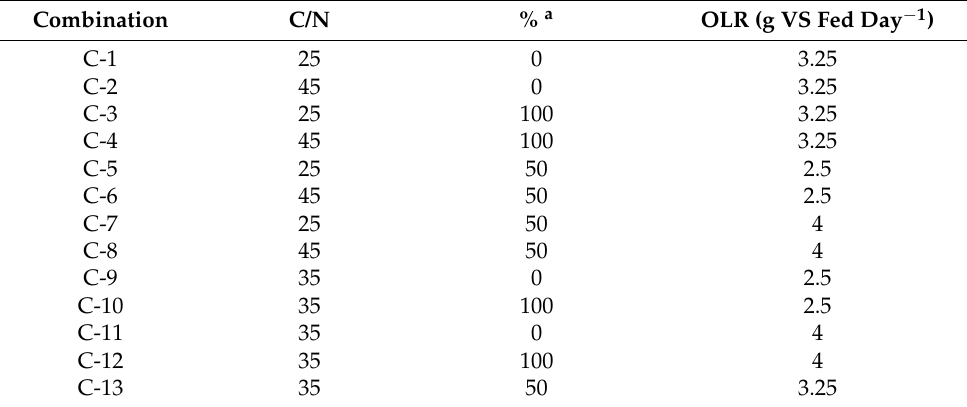
Table 2. Experimental design description and